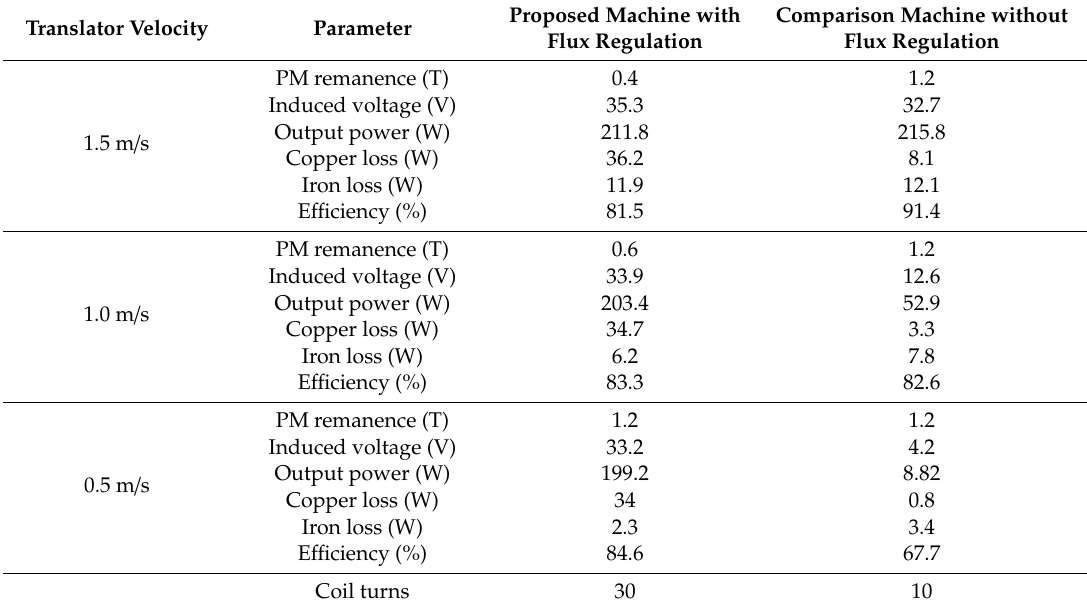
Table 3. Performance comparison at di ff erent translator